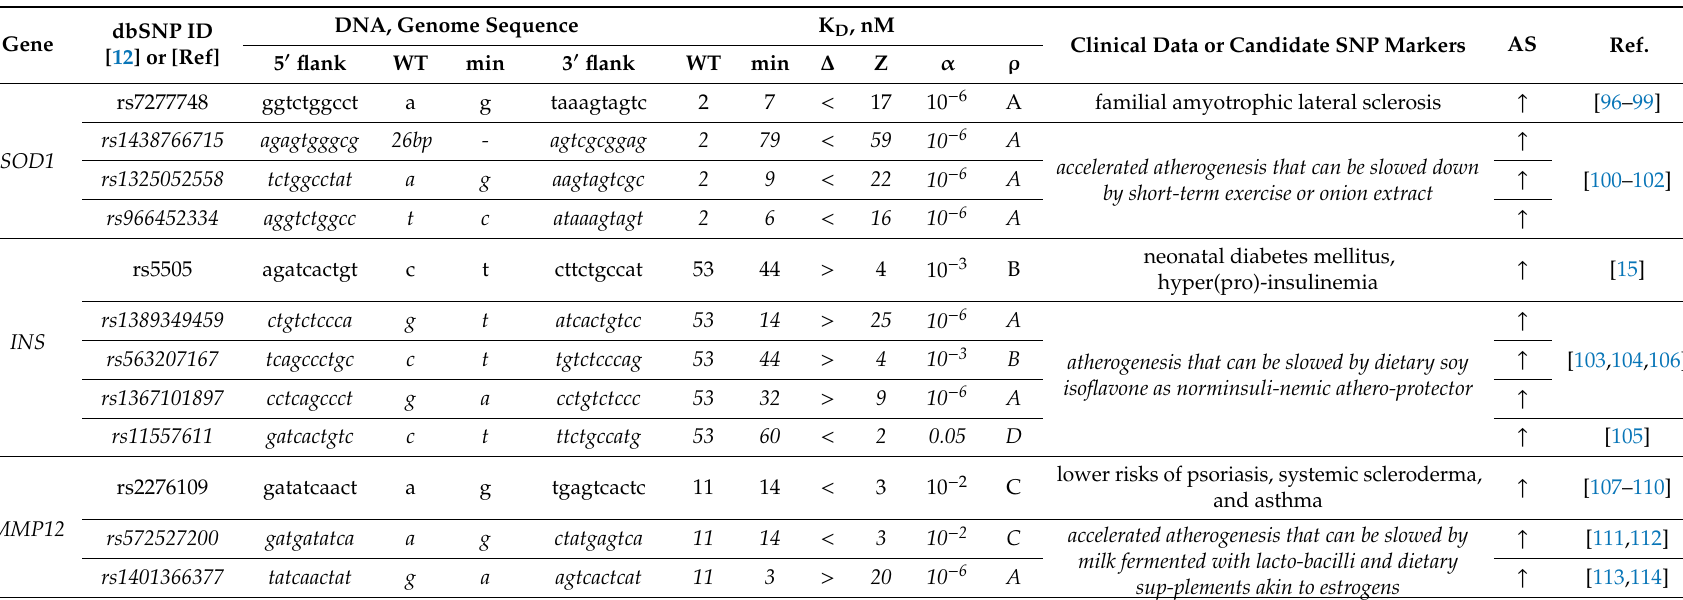
Clinical Data or Candidate SNP Markers AS Ref.